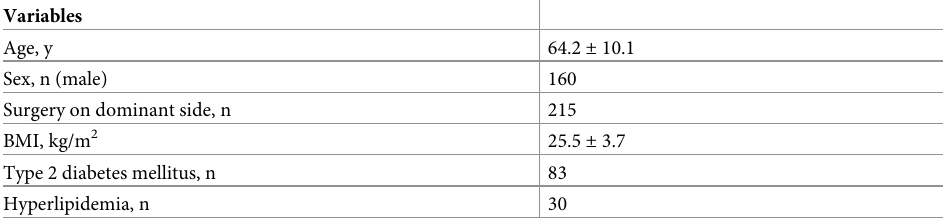
Table 1. Demographic characteristics of the patients undergoing anterolateral acromioplasty (n = 337).